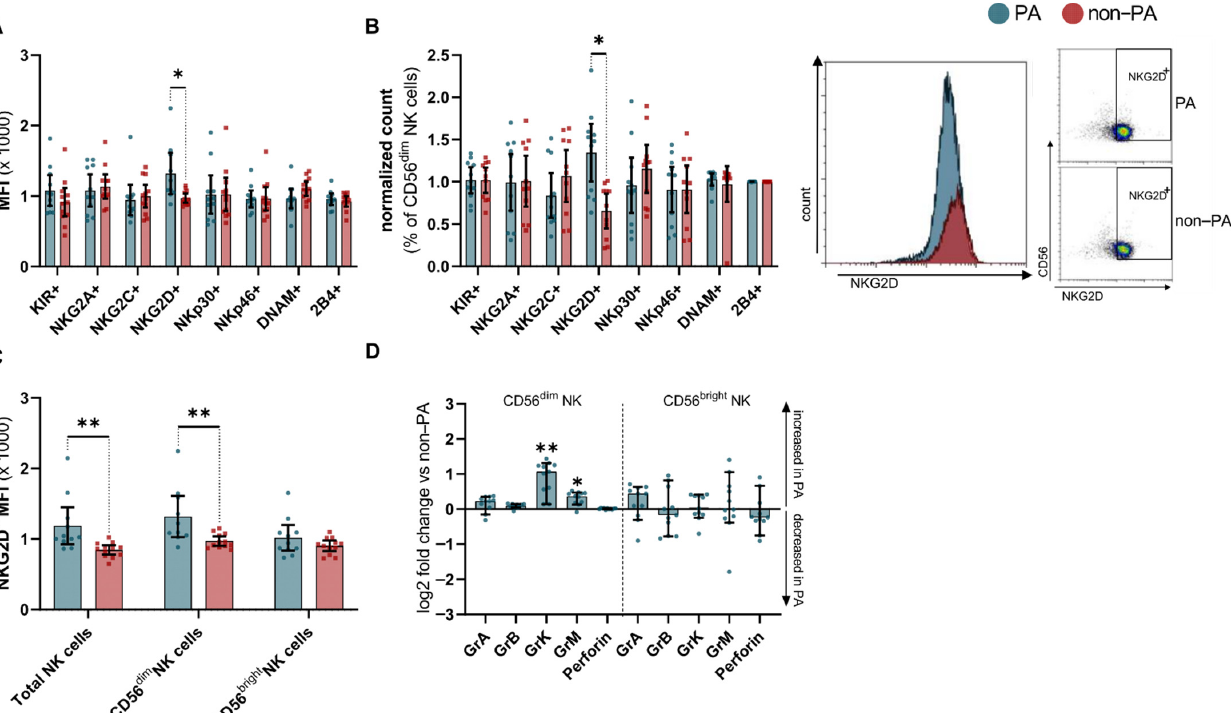
Figure 2. NK cell receptors are altered in IIM patients with pulmonary affection. ( A ) Normalized mean fluorescence intensity of NK cell surface receptors. ( B ) Relative cell number of CD56 dim staining positive for the respective NK cell surface receptor (left), and representative plots displaying differences of PA and non-PA (right). ( C ) MFI of NKG2D + on total NK cells and NK cell subsets, respectively. Differences were determined by Mann–Whitney test for PA (blue) and non-PA (red). ( D ) Relative cell numbers of CD56 dim and CD56 bright NK cells from PA patients expressing corresponding granzyme or perforin compared to non-PA. Statistical analysis was performed using Kruskal–Wallis one-way analysis of variance with Dunn multiple comparison test. Error bars display mean (IQR). To account for multiple comparisons, statistical significance was corrected by the false discovery rate (FDR). A threshold of Q = 5% was used for FDR. Abbreviations: Gr = granzyme, MFI = mean fluorescence intensity, NK = natural killer, PA = pulmonary affection ** p < 0.01, * p < 0.05.